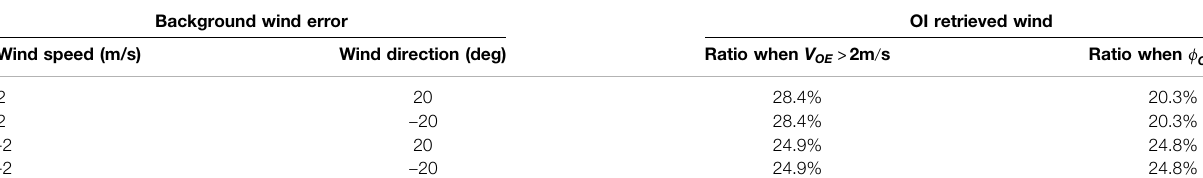
TABLE 3 | The ratios of OI-retrieved wind when the error is larger than background wind error.